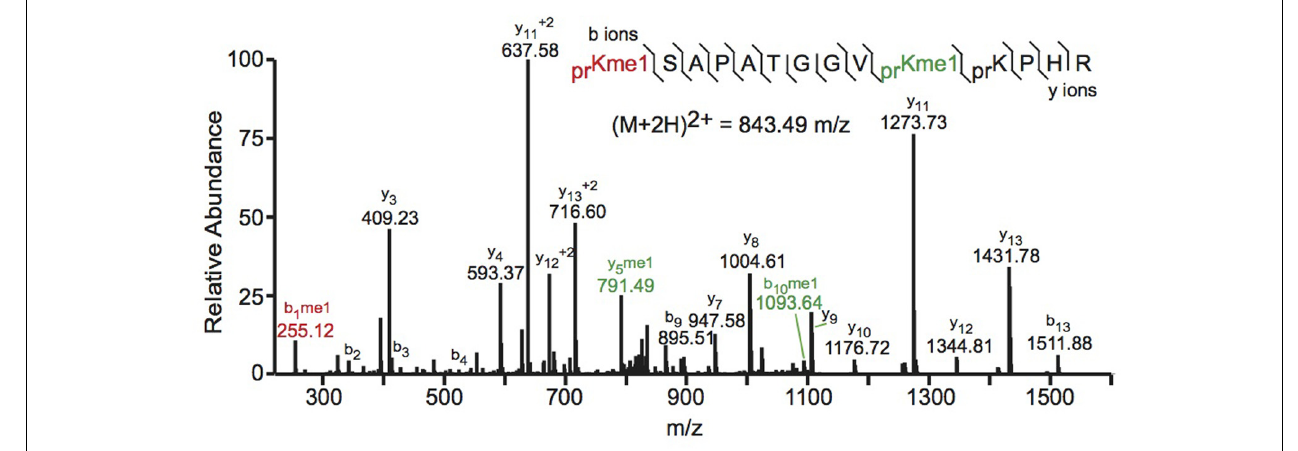
identify the K27me1 modification, and the fragment ions highlighted in green were used to assign the K36me1 modification. For example, the mass difference between the y4 and y5 ions is 198.12 Da, which corresponds to the mass of a propionylated and mono-methylated lysine residue, indicating that lysine 36 is monomethylated. Spectra is from data obtained in Zee etal.